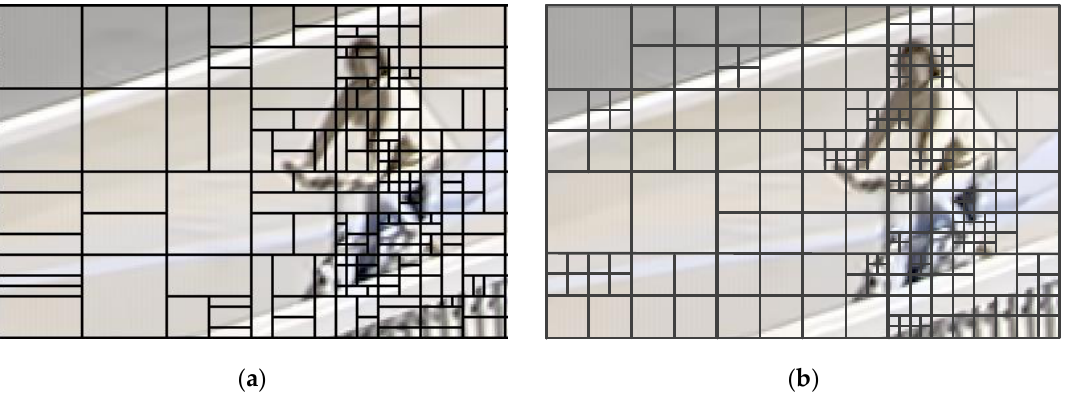
Figure 2. Comparison diagram of CU division of different coding standards. ( a ) In VVC; ( b ) in HEVC .